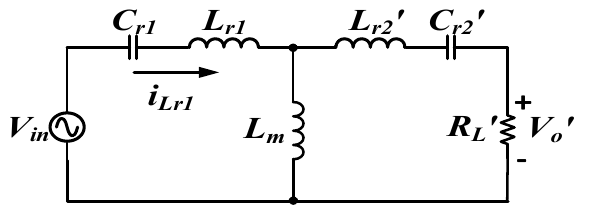
Figure 4. Equivalent circuit of a 2C3L resonant circuit in forward energy charging mode.